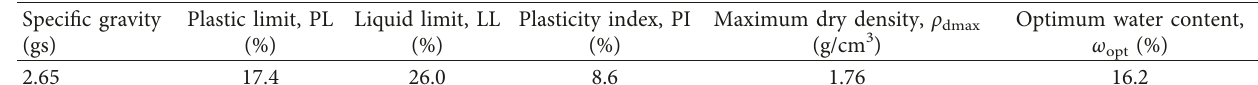
Figure 2: Schematic drawing of the compaction apparatus: (a) vertical view; (b) side view. Table 1: Physical properties of the compacted soils.